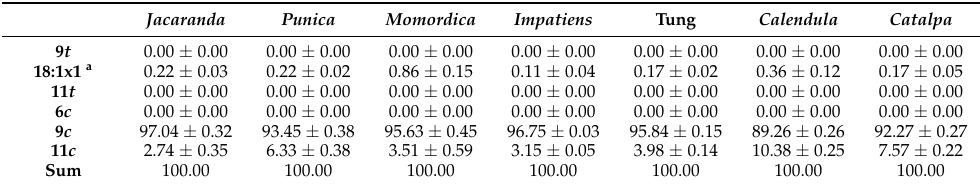
Table 3. C18:1 Isomer distribution. Entries are percentages of total integrated 18:1 FID signal and are the means of three independent determinations. Uncertainties are 95 % confidence limits based on the t -distribution with 2 degrees of freedom.